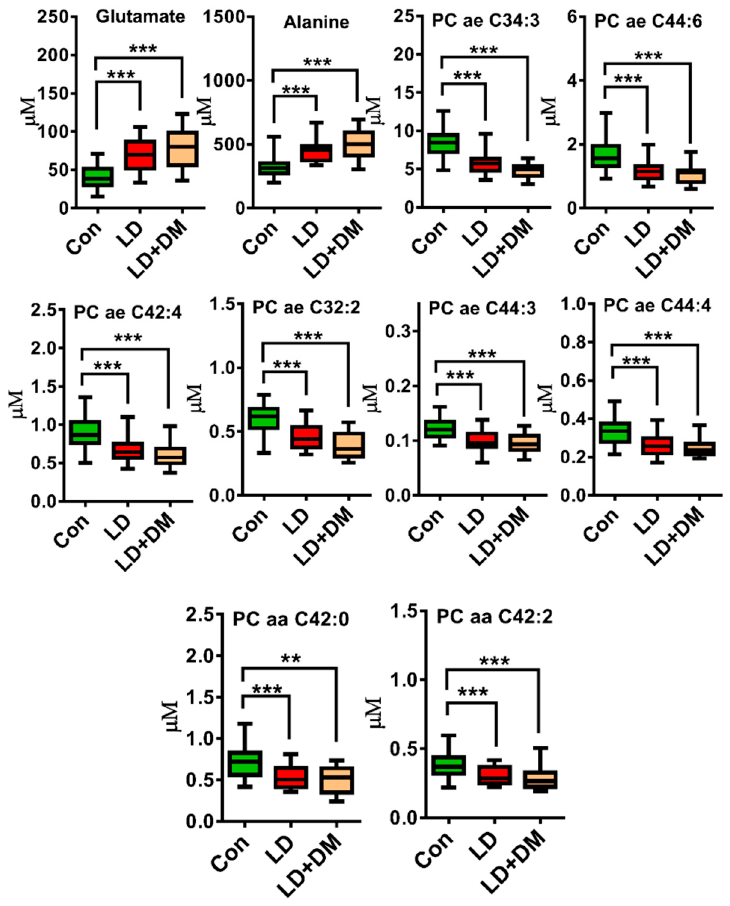
Figure 5. Bar charts of top 10 of 47 metabolites in control (green), lipid disorder (LD) (red) and lipid disorder with DM (LD + DM) (orange). ** q < 0.01; *** q < 0.001 ( p -value was adjusted for age, hypertension, CAD, stroke and CKD and was corrected with a false discovery rate (FDR). Table 2. Multivariate analysis for DM.